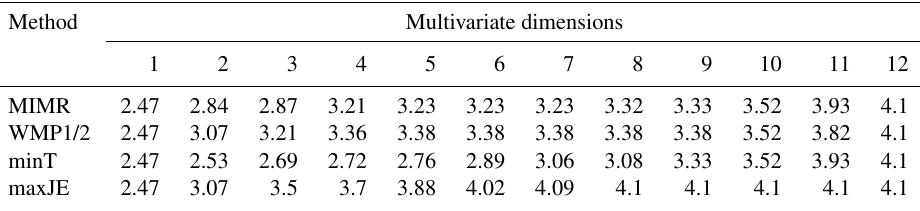
Table 2. Resulting maximum joint entropy (bits) for the different network sizes found with different methods for the Brazos River case study (JE used exhaustive optimization).